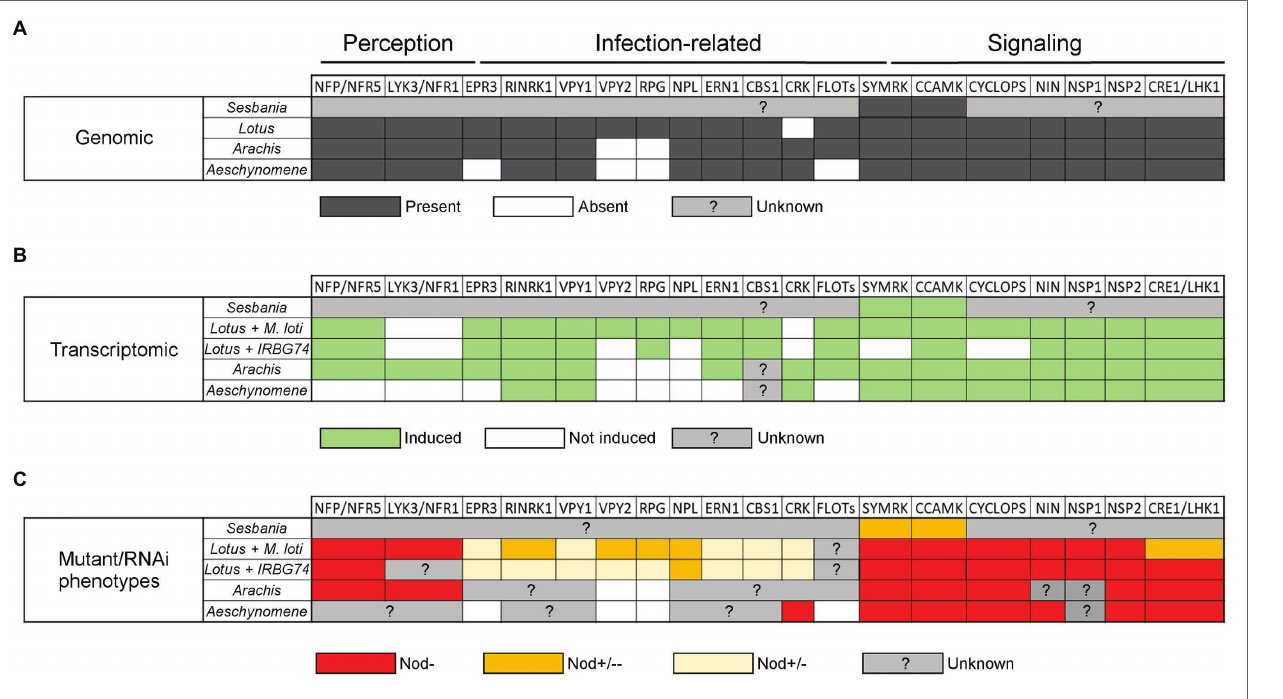
FIGURE 2 | Table comparing data on symbiotic genes involved in different nodulation steps in Arachis hypogaea , Aeschynomene evenia , Lotus japonicus , and Sesbania rostrata according to their symbionts. (A) Comparison of the presence (dark grey), absence (white), or unknown status (light grey) of symbiotic genes in the genome of A. hypogaea , A. evenia , L. japonicus , and S. rostrata . (B) Comparison of symbiotic genes that are induced (green), not induced (white) or of unknown status (grey) during nodulation in the four species. For L. japonicus this comparison includes the symbiont making intercellular infection (IRBG74) and intracellular infection ( M. loti ). (C) Comparison of the phenotypes with different genetic approaches (mutant or RNAi) in the four species and L. japonicus with the two symbionts. Red indicates absence of nodules (Nod-), orange indicates an intermediate strong phenotype (Nod+/ −− ), yellow indicates an intermediate weak phenotype (Nod+/ − ), and grey indicates the absence of data. For the Lotus -IRBG74 interaction, only transcriptome data of early time points is available (3, 5, and 10